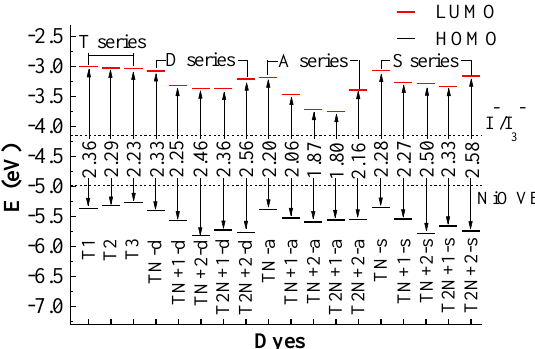
Figure 4. Frontier molecular orbital energy levels and energy gap, together with E VB (NiO) and E (I – /I 3 – ).